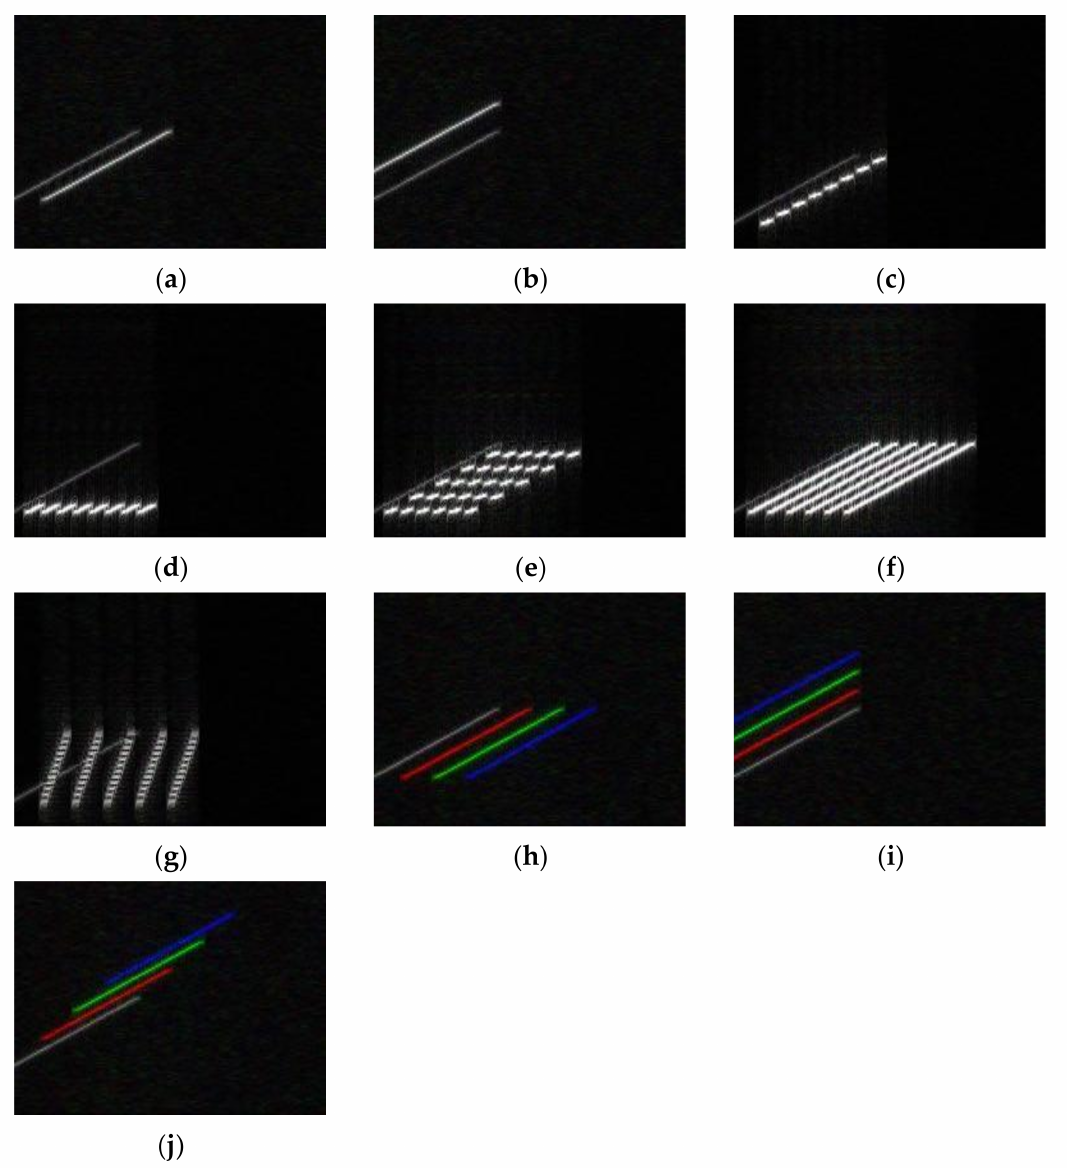
Figure 6. Multi-pulse jamming plus echo time–frequency diagram fusion. ( a ) RFTJ + echo. ( b ) VFTJ + echo. ( c ) ISDJ + echo. ( d ) PDTJ + echo. ( e ) ISRJ + echo. ( f ) WDTJ + echo. ( g ) SMSP + echo. ( h ) RGPO+ echo. ( i ) VGPO + echo. ( j ) R-VGPO+